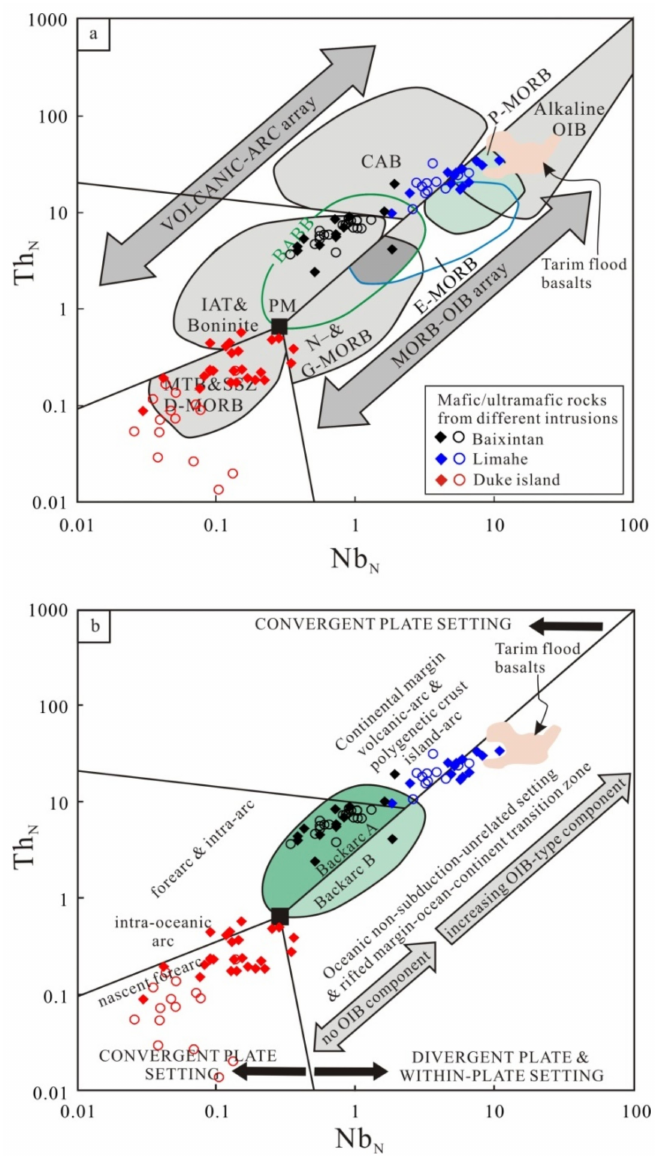
Figure 15. ( a ) The compositional variations of different intrusions on the Th N -Nb N diagram; ( b ) tectonic interpretation of different intrusions based on Th N -Nb N systematics (after [131]). Data sources are the same as in Figure 14. Abbreviations: MORB = mid-ocean ridge basalt, N-MORB = normal-type MORB, G-MORB = garnet-influenced MORB, E-MORB = enriched-type MORB, P- MORB = plume-type MORB, AB = alkaline ocean-island basalt, IAT = low-Ti island arc tholeiite, Boninite = very low-Ti boninitic basalt, CAB = calc-alkaline basalt, MTB = medium-Ti basalt, SSZ = supra-subduction zone, D-MORB = depleted-type MORB, BABB = back-arc basin basalt, Back-arc A = BABB characterized by input of subduction or crustal components, and Back-arc B = BABB showing no input of subduction or crustal components. In both panels, Nb and Th are normalized to the N-MORB composition